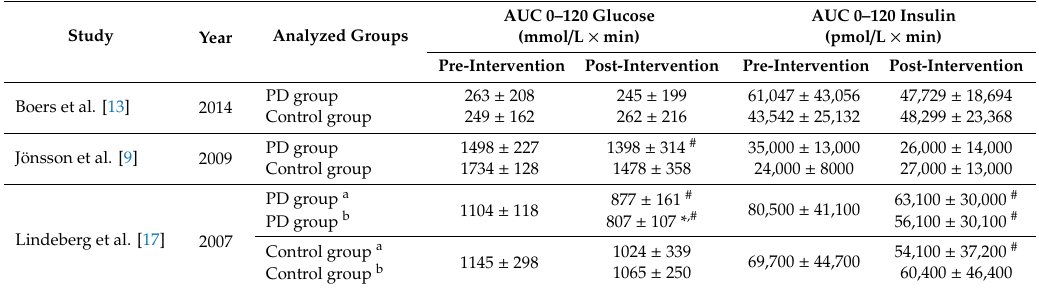
Table 4. E ff ect of the Paleolithic diet on AUC 0–120 glucose and AUC 0–120 insulin (mean ±